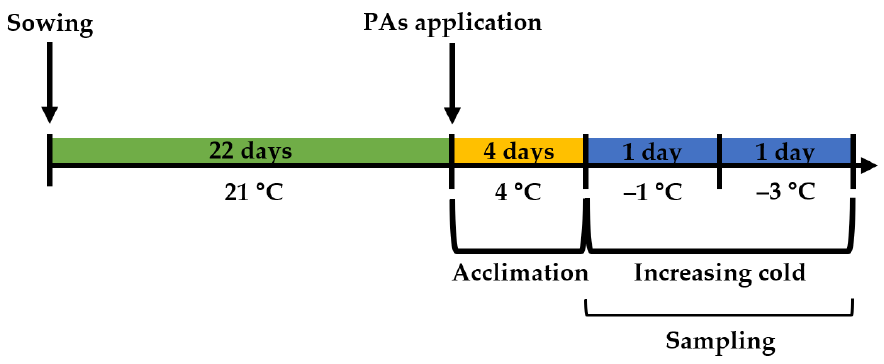
Figure 5. The design of the experiment.